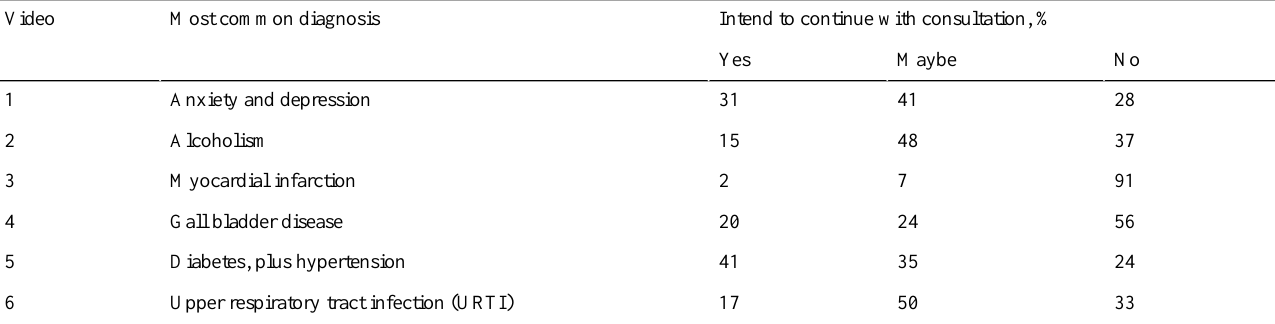
Intend to continue with consultation, %Most common